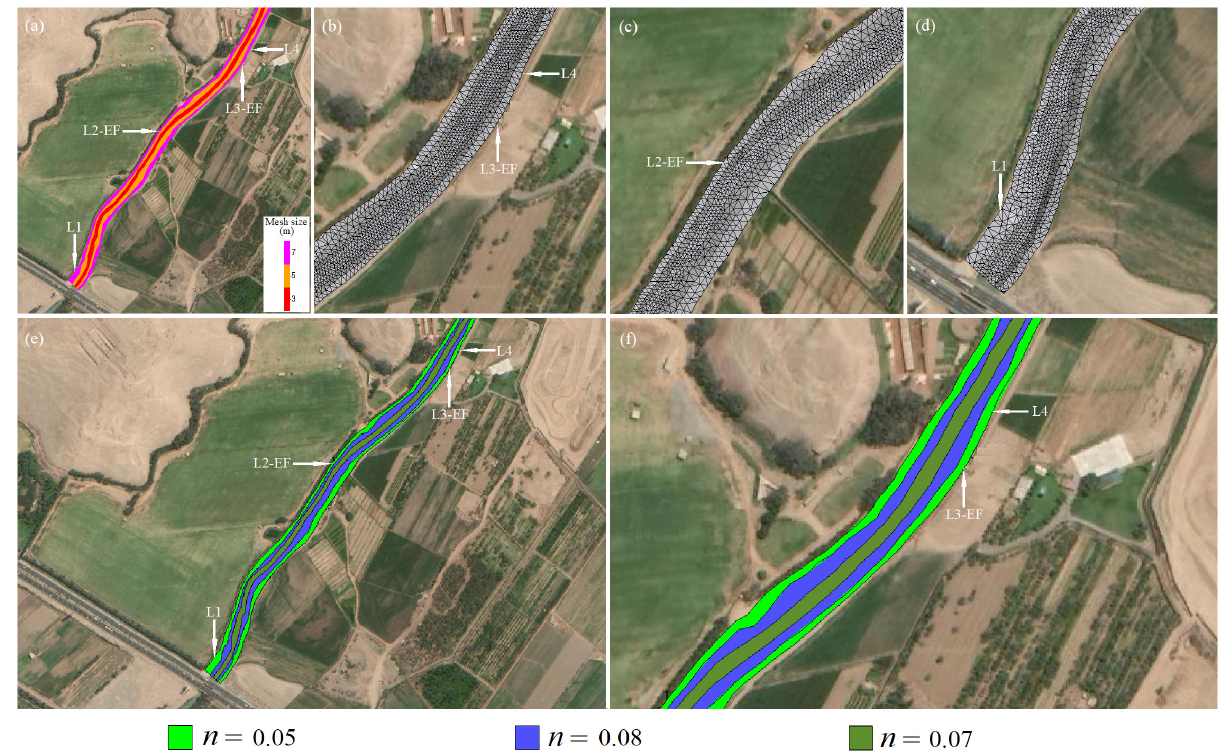
Figure 2. ( a ) Mesh size, ( b ) Mesh with DEM interpolation in L3-EF and L4, ( c ) Mesh with DEM interpolation in L2-EF, ( d ) Mesh with DEM interpolation in L1, ( e ) n in the lower part of the study section from L4 to L1, ( f ) n in L3-EF and L1. n is the is Manning’s roughness coefficient.